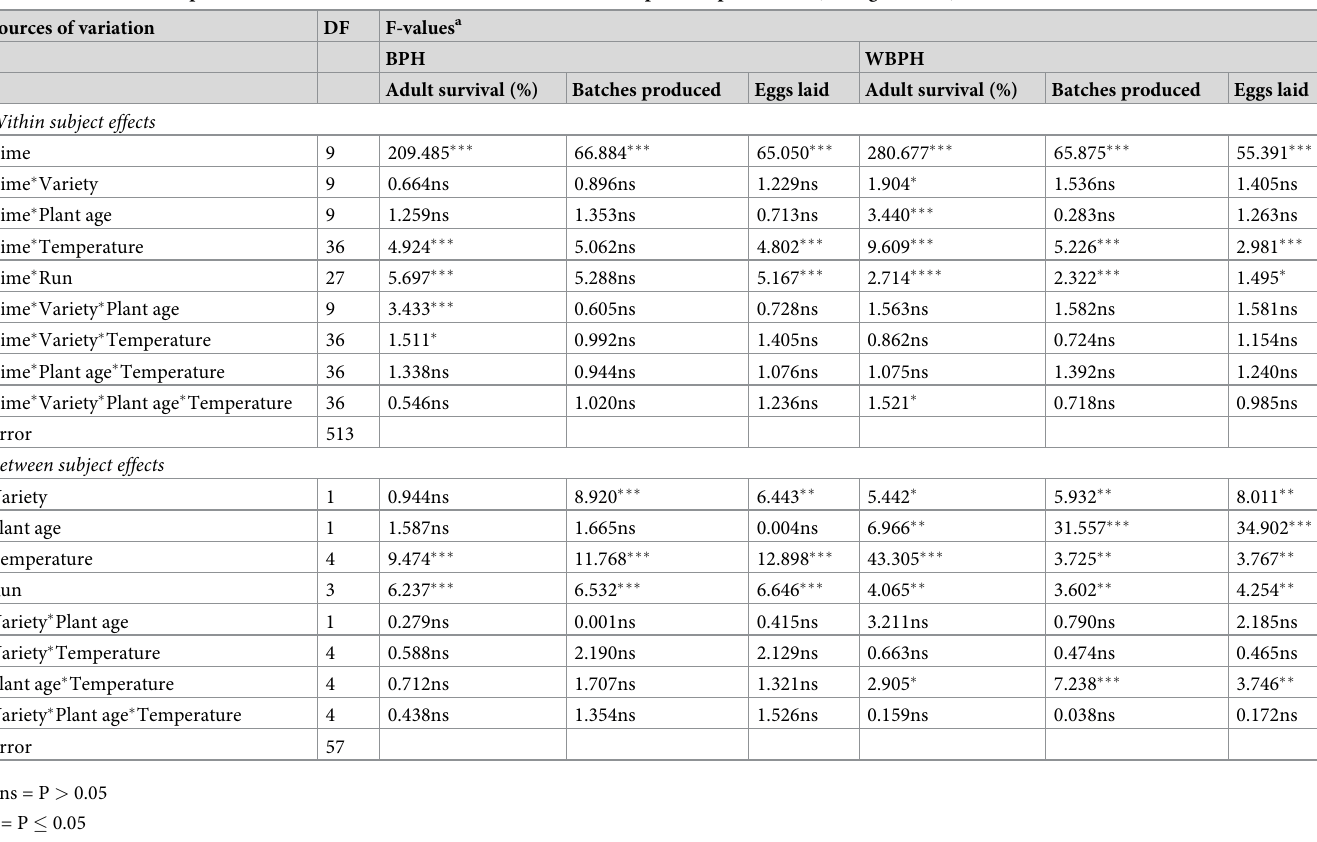
Table 2. Results from repeated measures GLMs of adult female survival and oviposition parameters (see Figs 2 and